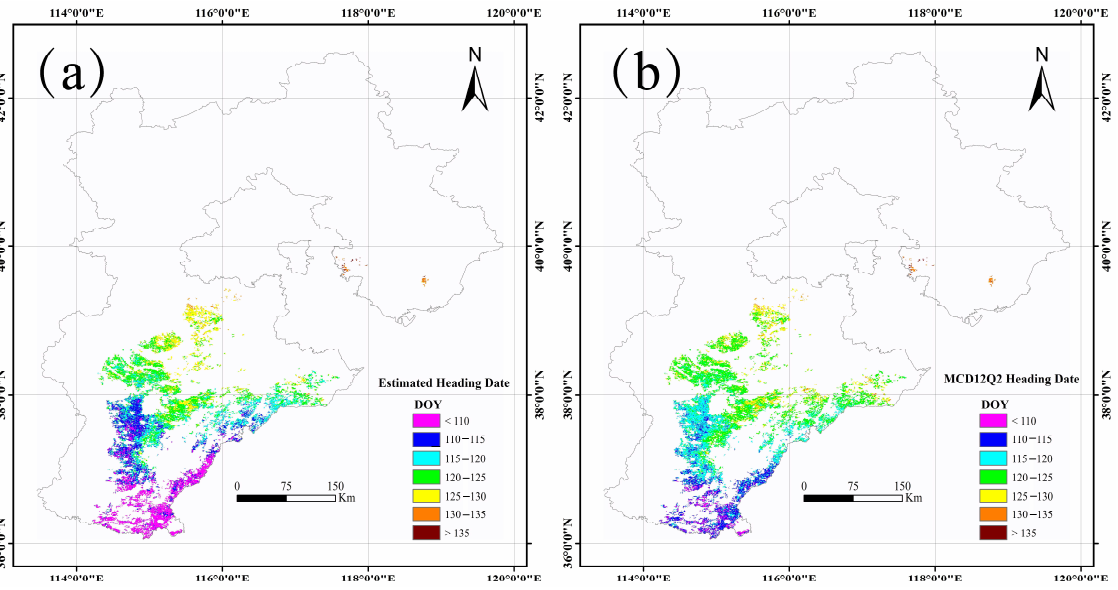
Figure 4. Spatial distribution of winter wheat HD by ( a ) estimation and ( b ) MCD12Q2 product.